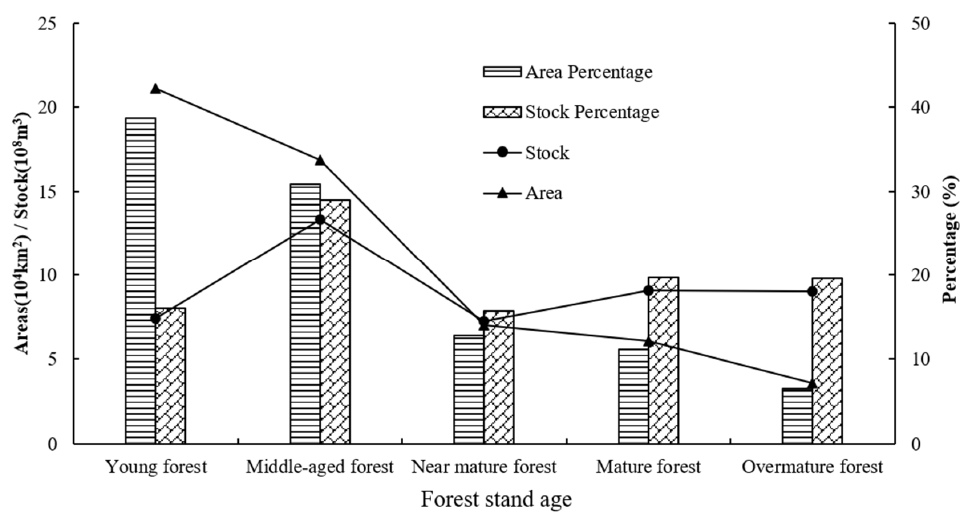
Figure 9. Forest area, forest volume stock, and their corresponding percentage in the YRB.